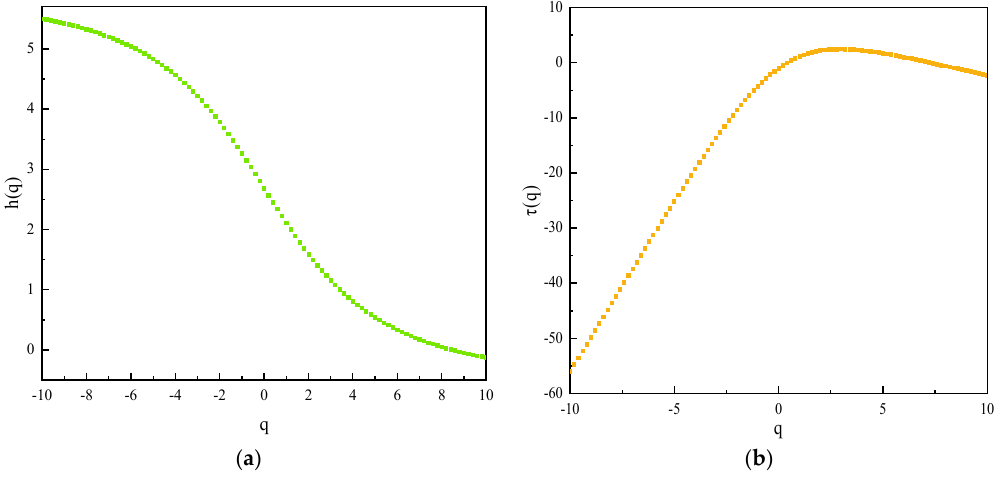
Figure 11. Generalized Hurst exponent ( a ) and scaling function ( b ).